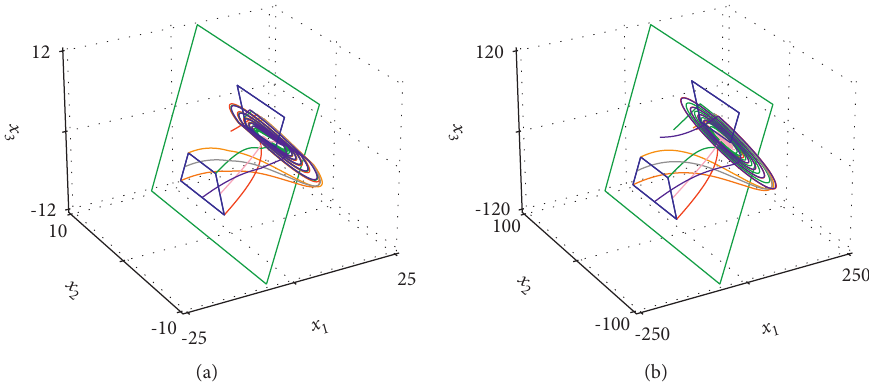
with a � 0 . 2, b � 5, c � − 7, α � 1 and different 1